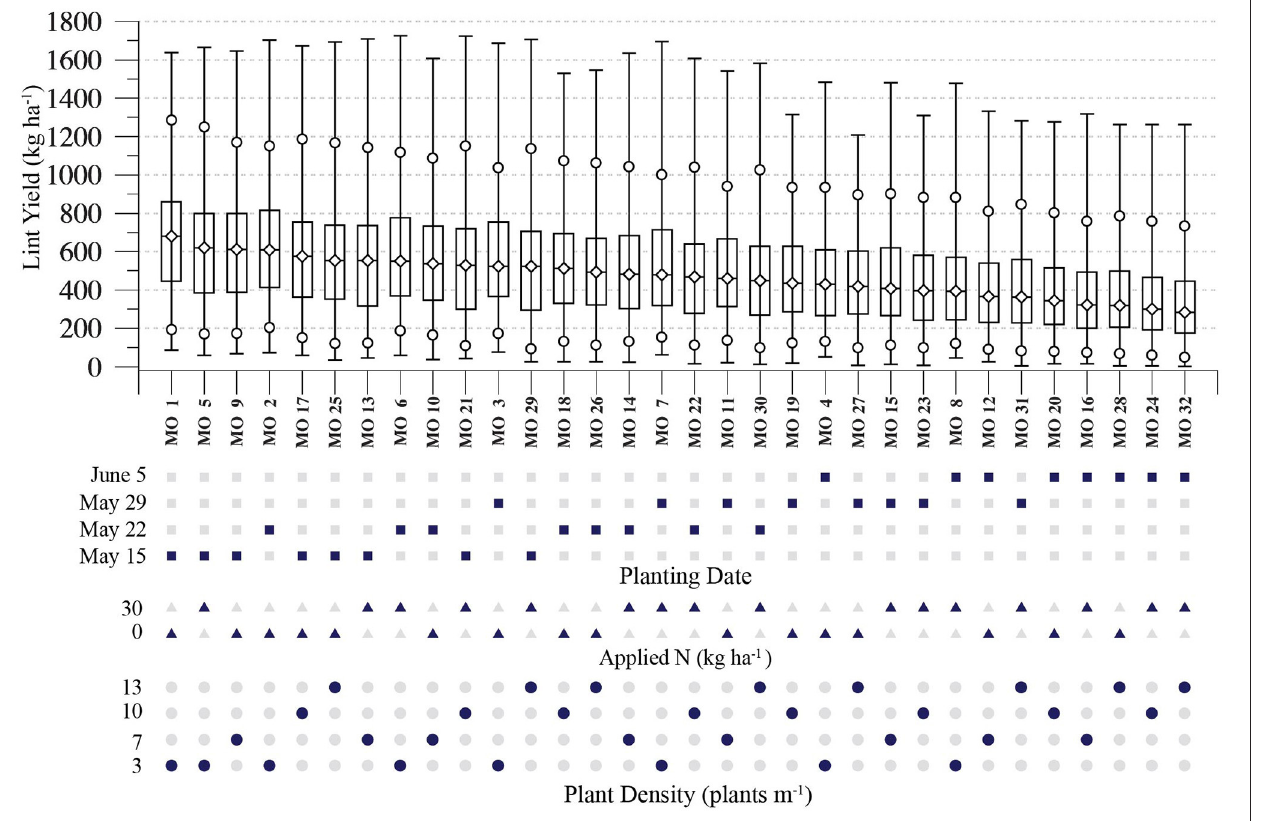
distribution’s medians, 25th, and 75th percentiles. Between May 14 and June 5 the simulated median lint yields decrease nearly linearly, with a linear-fit slope dropping 11.76 kg ha − 1 with every day’s delay in planting.